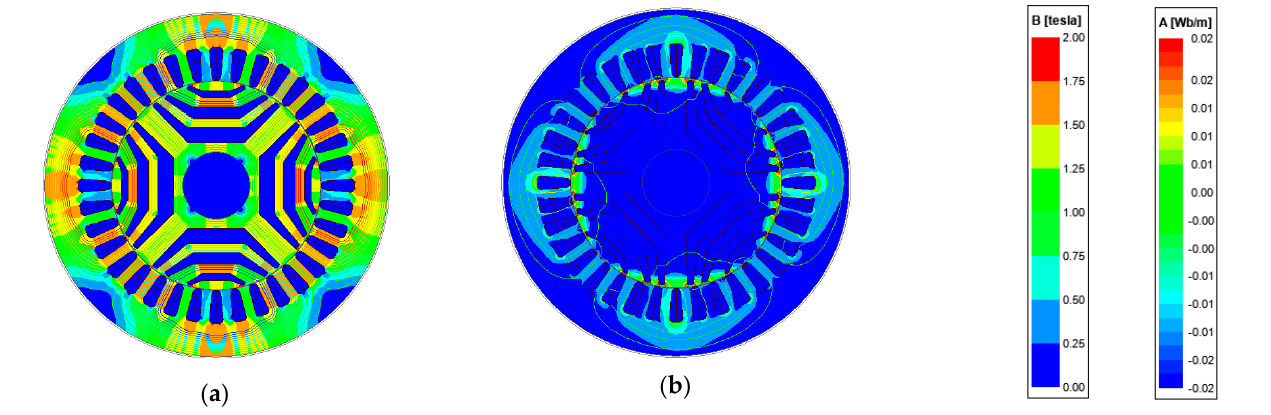
Figure 12. Distribution of flux density and flux lines at standstill and at the peak of the rated current at ( a ) position of the minimum reluctance (d-axis) and ( b ) position of the maximum reluctance ( q -axis). Finally, the d -axis and q -axis inductance and flux linkage can be obtained by (26) and (27) respectively. The simulated and measured values of the dq -axis flux linkages ( λ d ( i d , 0 ) (cid:0) (cid:1) and λ q 0, i q ) of the five-phase SynRM are shown in Figure 13. There was an acceptable agreement between the measured and simulated